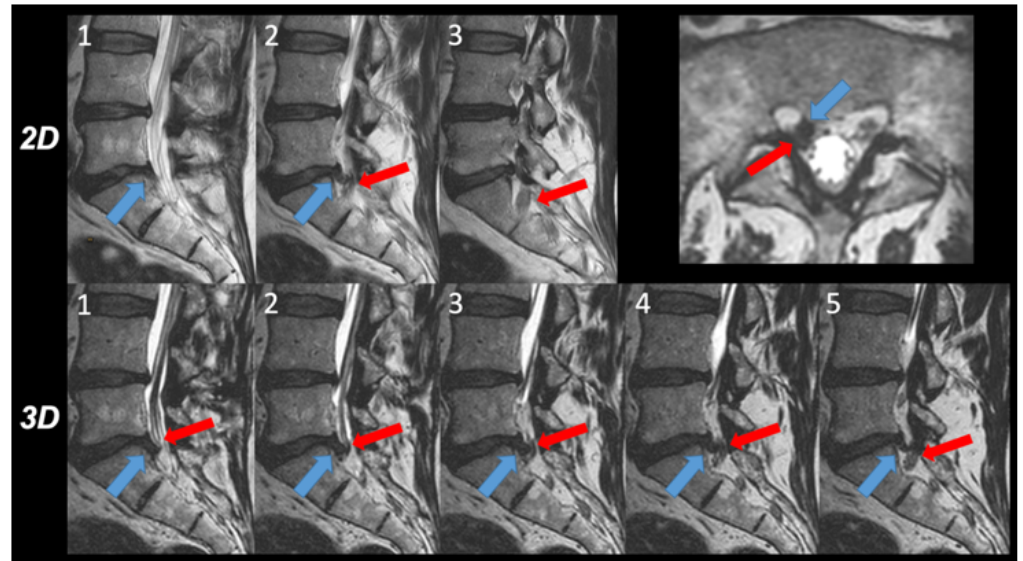
Figure 2. Intra-individual comparison of the 2D and 3D images. The relationship between disc herniation (blue arrow) and nerve root (red arrow) within the lateral recess right side was evaluated on three consecutive 2D T2w TSE images (upper row 1 to 3) and on five 3D T2w TSE images (lower row 1 to 5) depicting each second image. On 2D T2w TSE images, a contact between the disc herniation and the nerve root is depicted in image 2, graded as 1 according to the Pfirrmann grading system. However, in 3D T2w TSE images, a deviation and compression of the nerve root, corresponding to grade 3, was obvious in images 2, 3, and 4 and verified in the transverse thin slice reformatted image.